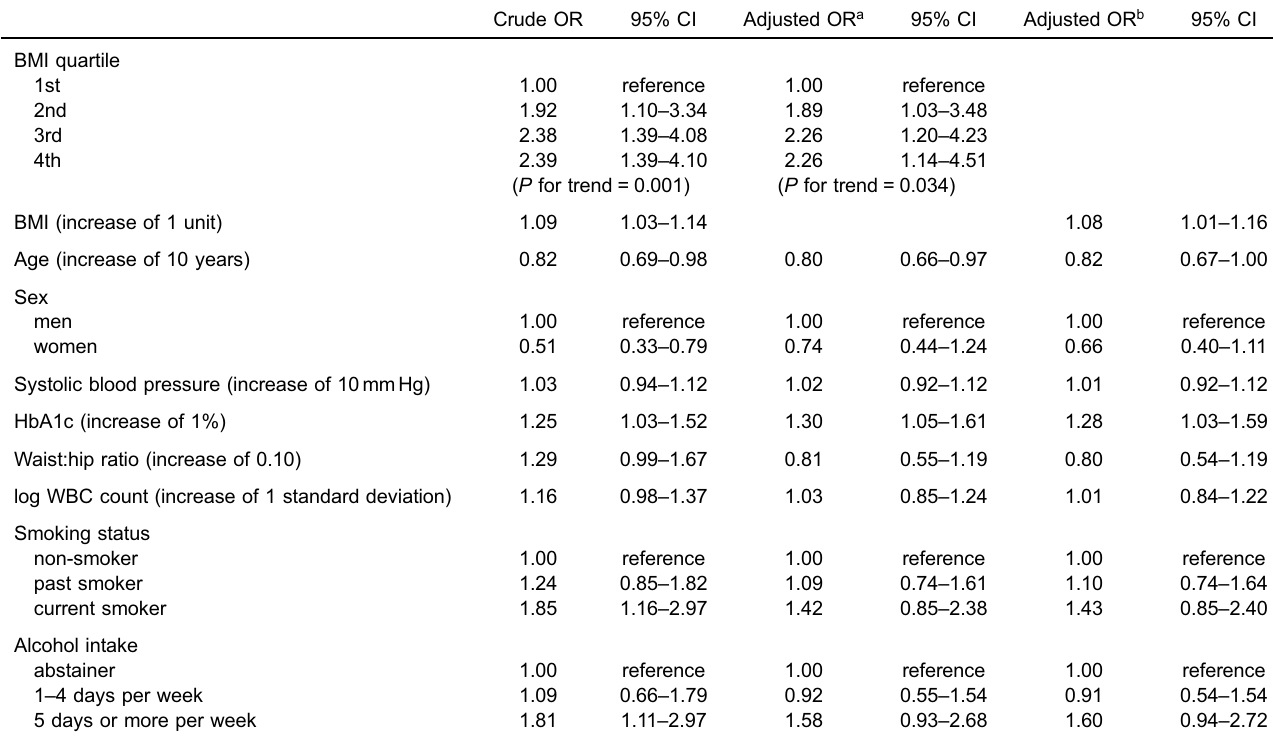
Table 2. The odds ratios of having paranasal sinus disease according to body mass index Crude